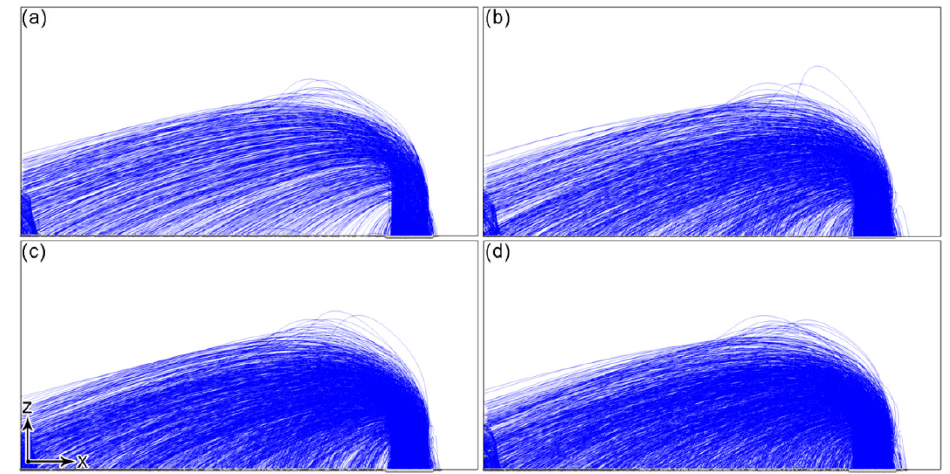
Figure 9. Comparison of data for different simulation schemes and experimental data: ( a ) number of spatters-time curves for different simulation schemes; ( b ) experimentally obtained number of spatters for different powder layer thicknesses (adapted from reference [30]); ( c ) width of denudation zone for different simulation schemes; ( d ) maximum height of spatters for different simulation schemes.